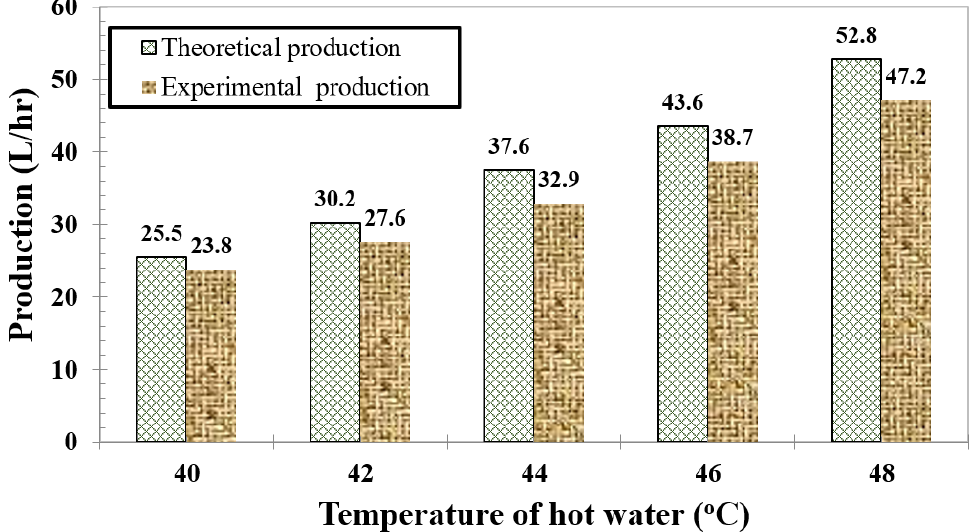
Figure 16. GOR of the solar HD desalination unit versus hot seawater temperature.